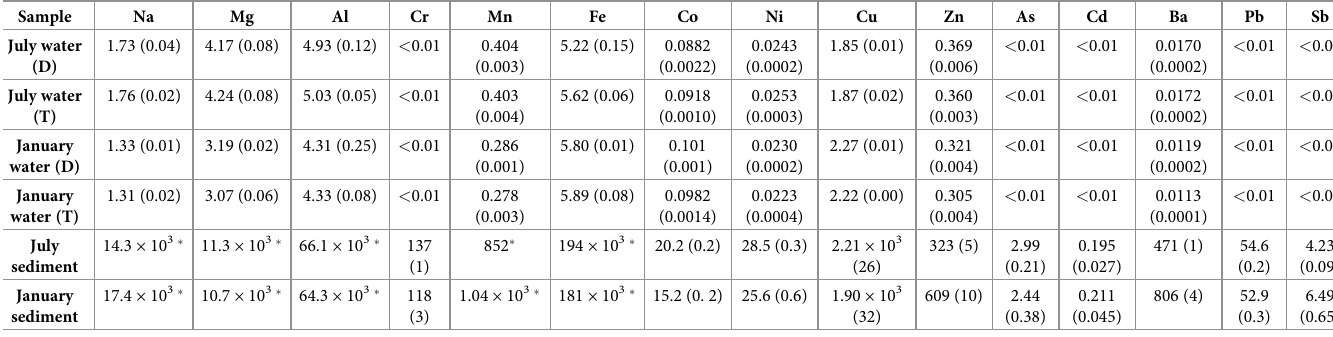
Table 1. Chemical composition of samples.